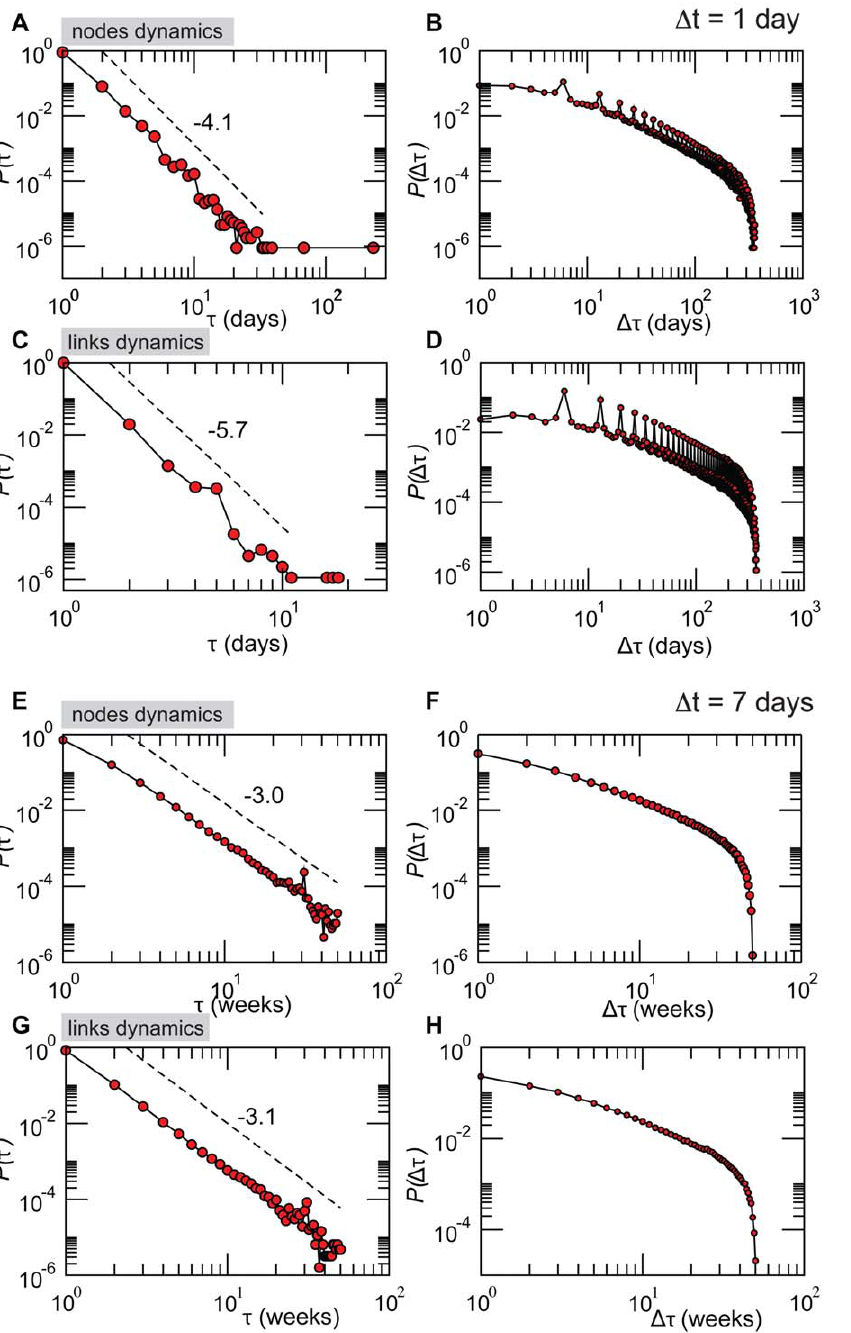
Figure 6. Probability distributions of the duration t of activity and of the duration Dt of inactivity of nodes and links. Results are reported for daily (panels A to D) and weekly (panels E to H) networks. In the daily case, weekend breaks are neglected as they are characterized by a much lower activity and clear weekly patterns (see Figure S3). The observed peaks in P ( D t ) of the daily networks correspond to inactivity periods of multiples of a week. doi:10.1371/journal.pone.0019869.g006 S w T : ln (1 = a ) , where S w T is the average weight in the network. We sets of edges E 1 and E 2 is defined by j E 1 \ E 2 j = j E 1 | E 2 j . Figure 10 have considered both filtering procedures for the aggregated networks displays the distributions of the growth rates of the links’ weights w A in the various backbones, compared with the corresponding with D t ~ 28 days, and constructed for each network the correspond- distribution in the whole network, together with the overlaps of the ing backbones for various significance levels. In order to assess how monthly backbones in color-coded matrices. The overlap between the network backbone change in time, we have then computed the backbones of successive monthly networks is substantial but not large, overlap between the 13 | 12 = 2 pairs of backbones, at a given approximately ranging from 25 to 30%. If we assume that the two significance level, where the overlap of two networks with respective